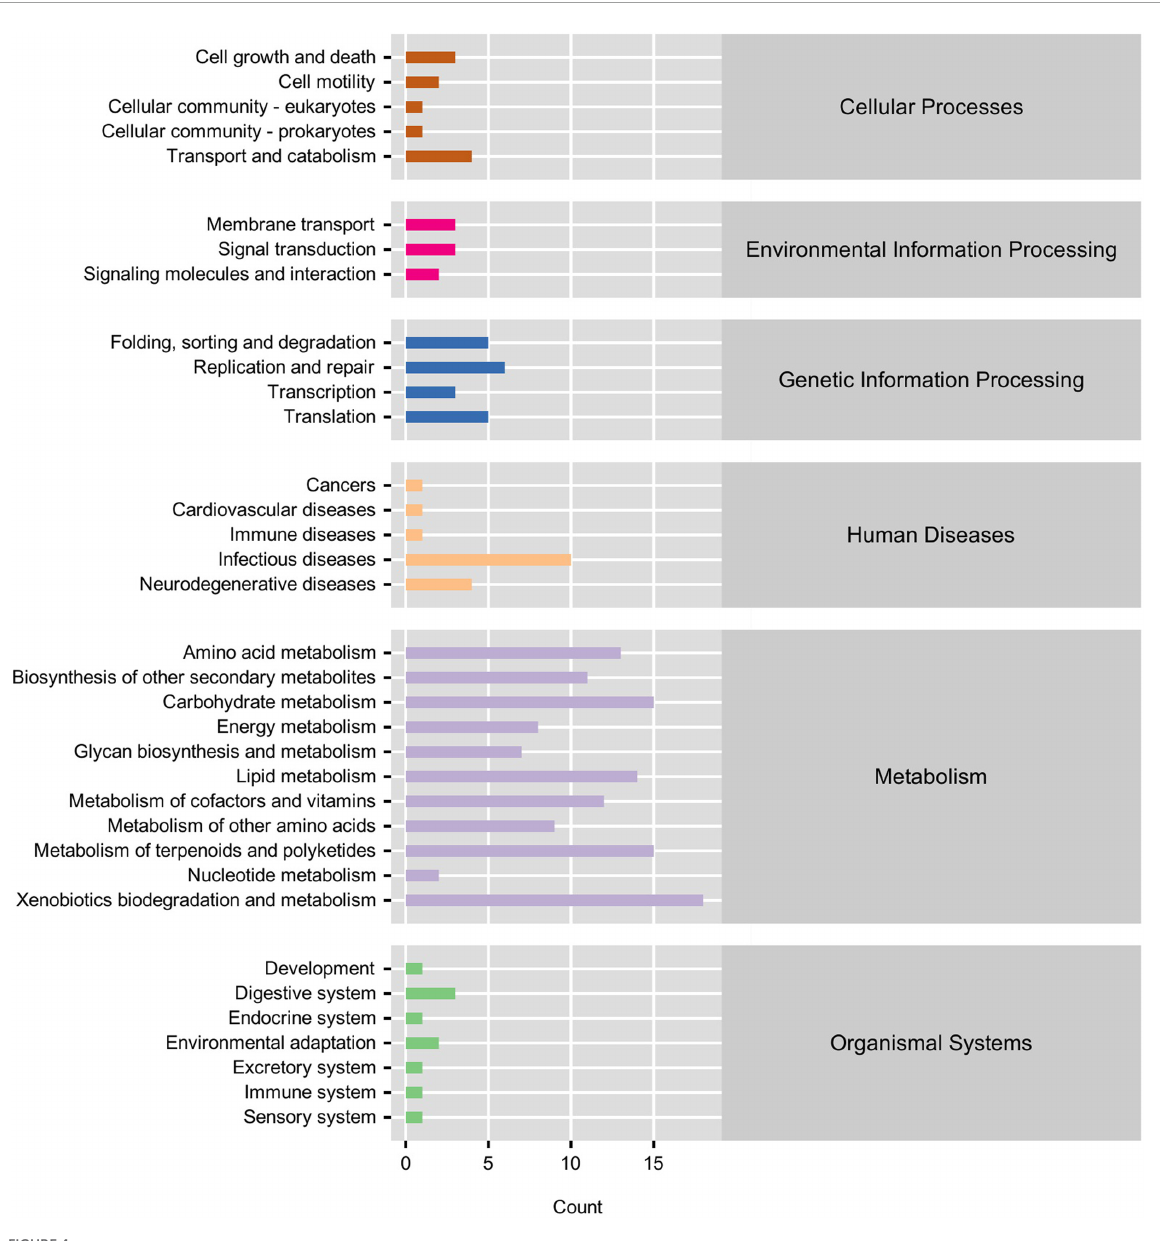
FIGURE4 Functional annotations and abundance information about the intestinal microbiota at KEGG level 1 and level 2. The gene function is showed as color-bars (level 1). The detailed pathways are shown on the left side (level